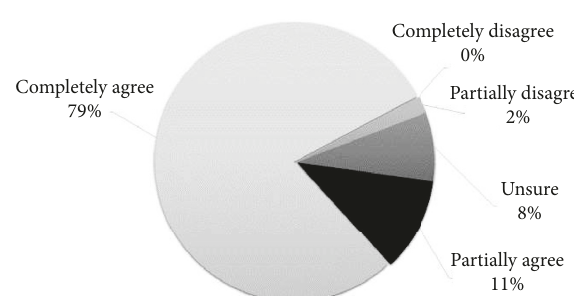
Figure 2: Confidence toward child